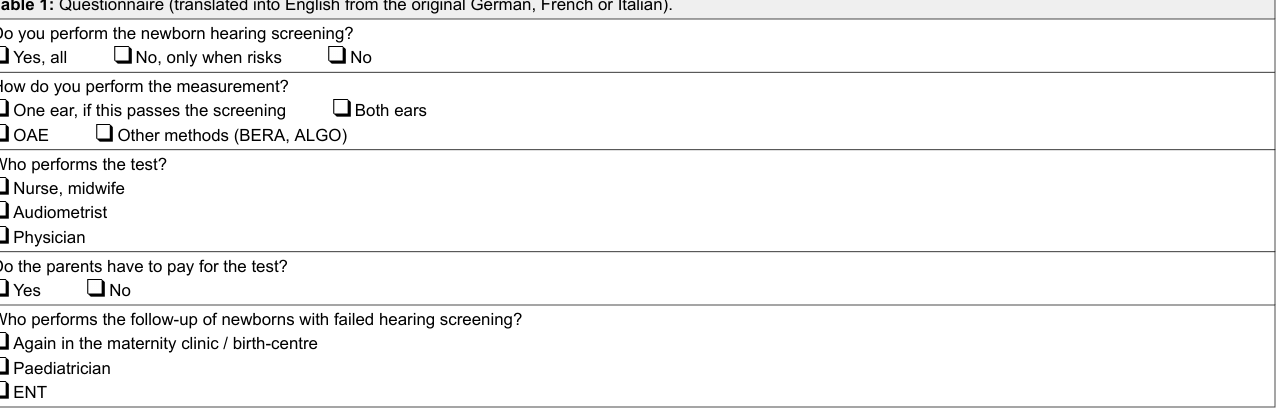
Table 1: Questionnaire (translated into English from the original German, French or